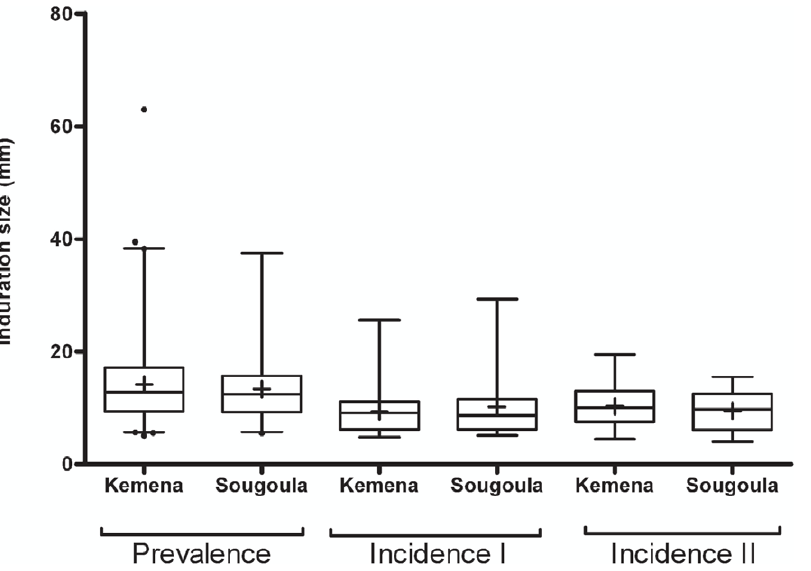
Figure 3. LST reaction size in Kemena and Sougoula. Induration size of LST reactions for study subjects in Kemena and Sougoula during prevalence and incidence surveys. All measurements over zero were included in the ‘‘box and whiskers’’ plot. The box represents the 25th and 75th percentiles. The median is represented by a solid horizontal line and the mean by a ( + ). The whiskers of the graph show the 1st percentile to the 99th percentile. Values lower than the first percentile and greater than the 99th percentile are represented by a ( N